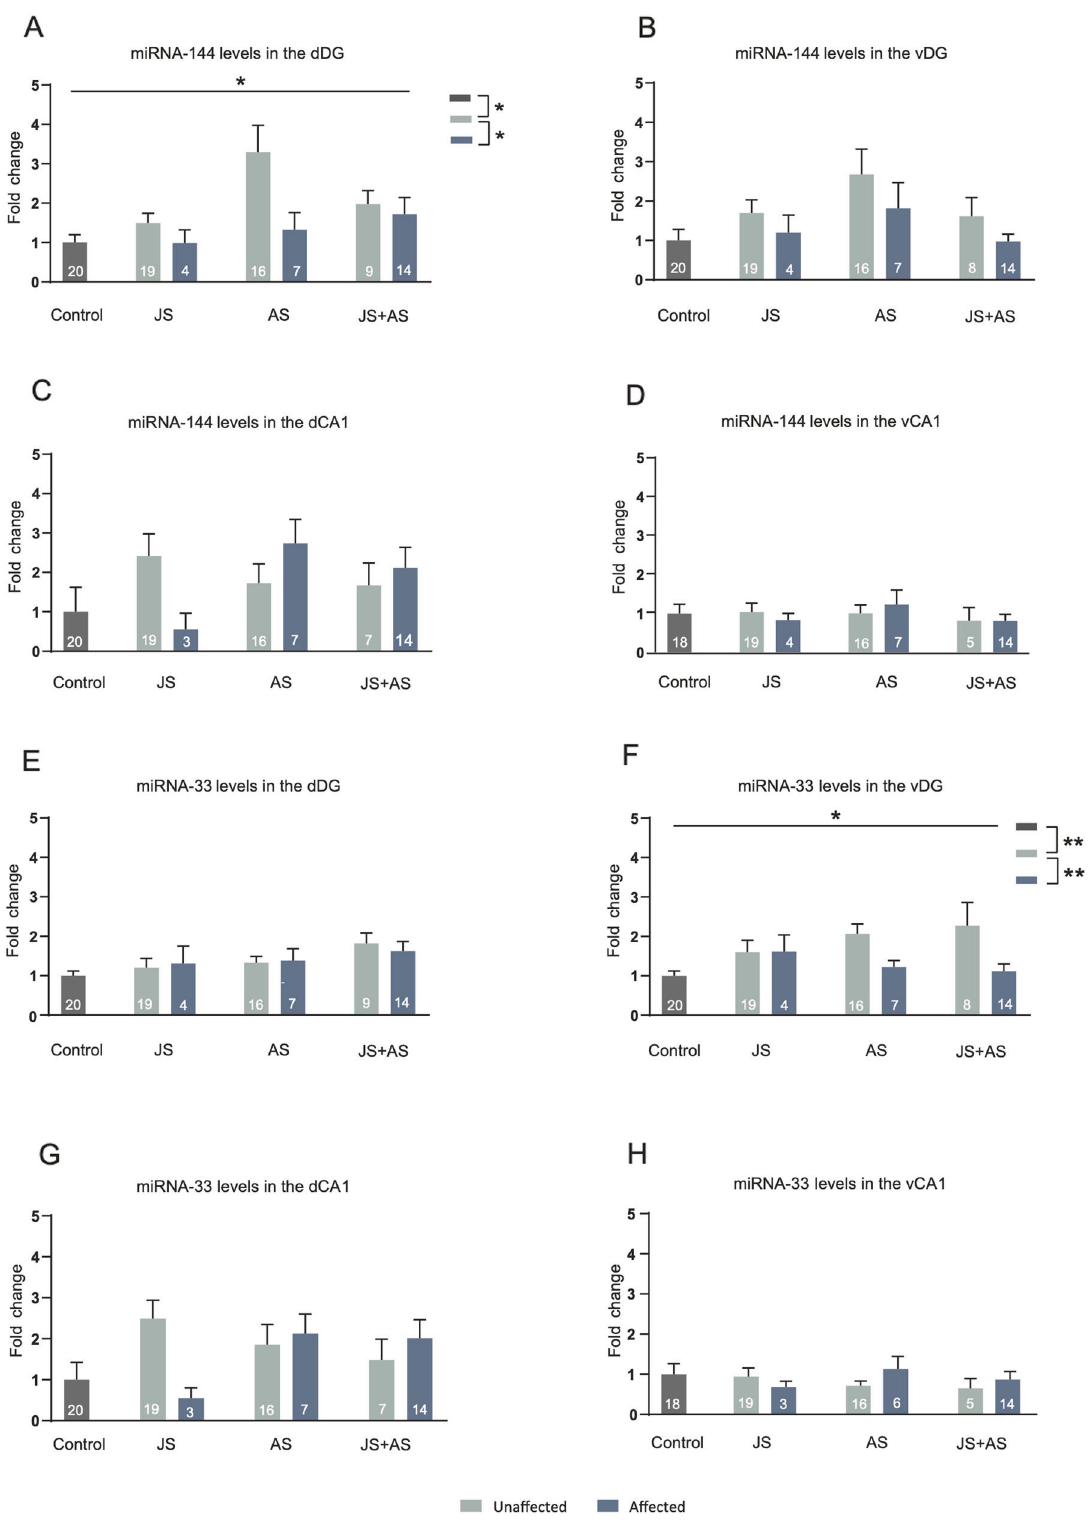
Fig. 3 miRNA levels in affected and unaffected male rats. A Increase in miRNA-144 levels occurred exclusively in the dorsal dentate gyrus (dDG) of unaffected rats with a history of JS, AS or combined JS + AS, whereas no main effects for stress exposure group or behavioral pro fi le were observed in the ventral dentate gyrus (vDG) ( B ), dorsal Cornu Ammonis 1 (dCA1). C or ventral CA1 (vCA1) ( D ). Within the vDG, an increase in miRNA-33 expression was evident in stress-exposed, but unaffected rats ( F ). No main effects for group or pro fi le were observed for miRNA-33 expression in the dDG ( E ) dCA1 ( G ) and vCA1 ( H ). Data presented as means and standard errors of fold-change, relative to control. *Signi fi cant difference between pro fi les, p < 0.05, ** p <